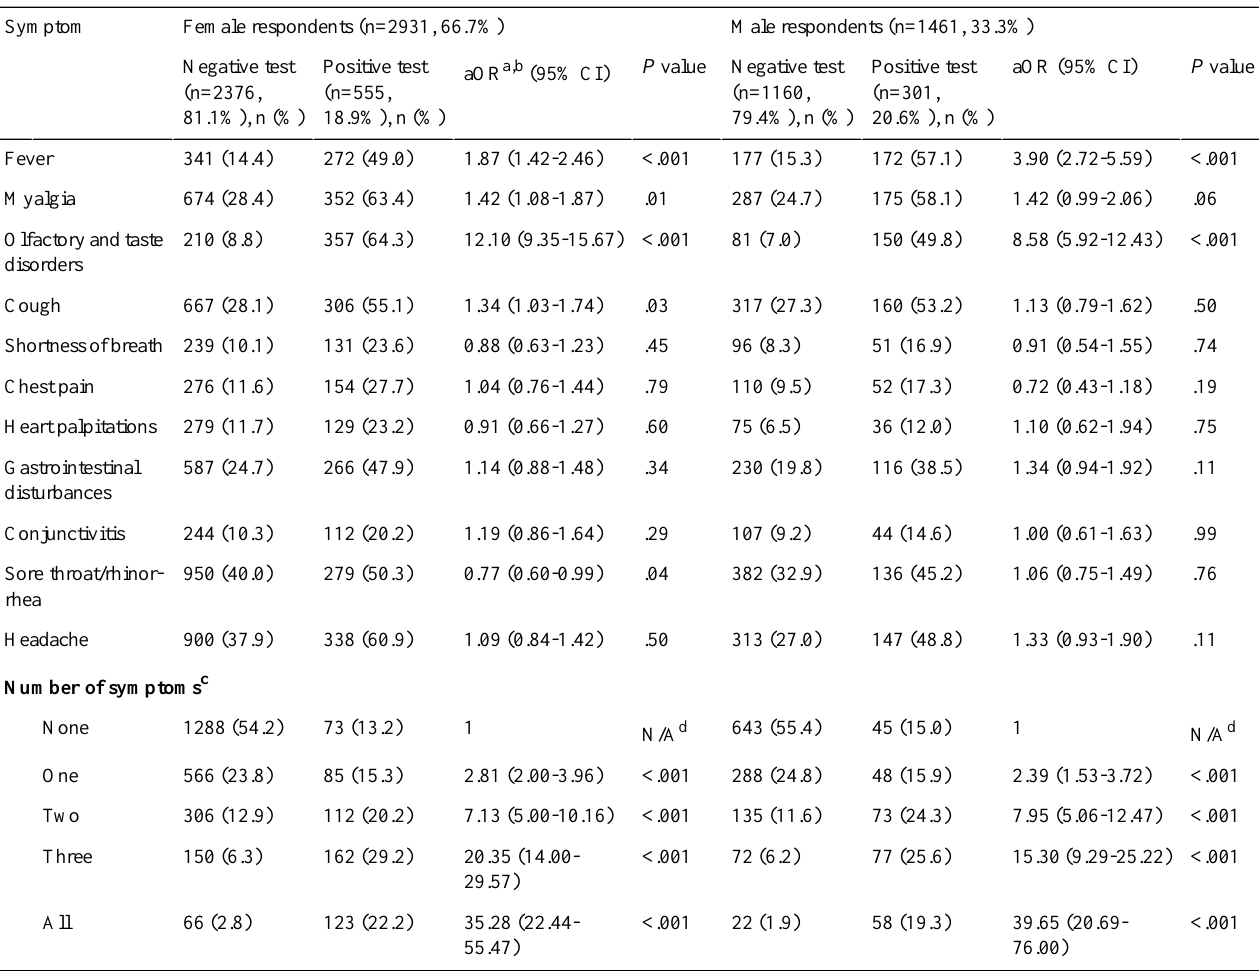
Table 4. Sex-specific adjusted odds ratios of positive molecular tests in nonhospitalized survey respondents with known molecular test results (n=4392, subsample